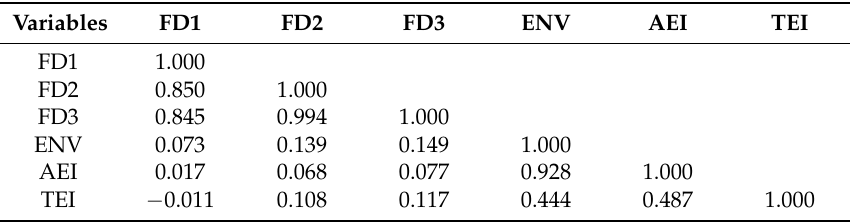
Table 3. Panel correlation analysis of the BRI region.